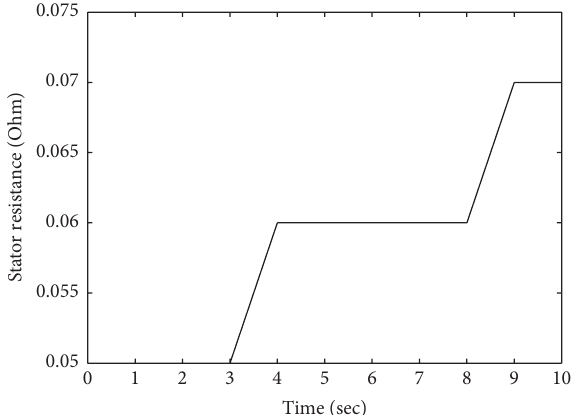
Figure 10: Time profile of the stator